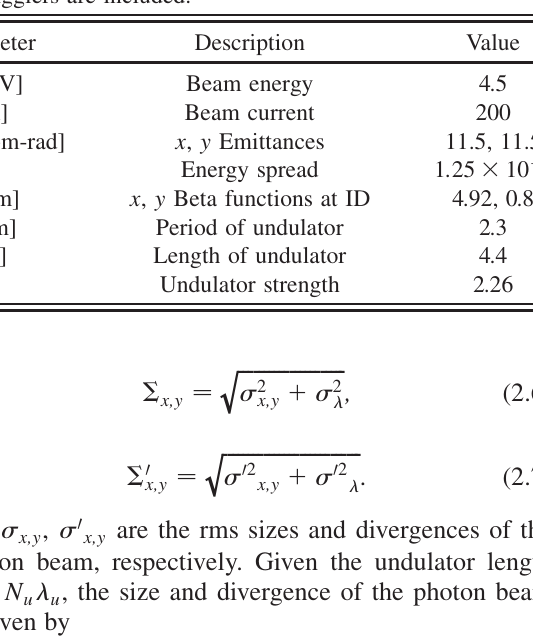
ULTIMATE STORAGE RING BASED ON FOURTH-ORDER . . TABLE I. Main parameters of PEP-X as an ultimate storage ring. The effects of the intrabeam scattering and 90 m of damp- ing wigglers are included.